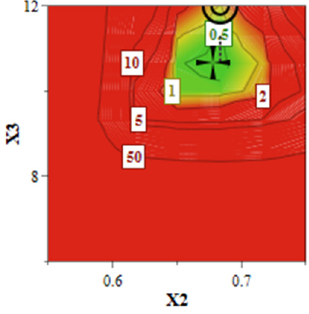
Figure 5. The Design Space of SIM-DOX-LCL formulation. X 2 : DOX concentration (mM); X 3 : SIM concentration (mM). Table 4. The composition of the optimal formulation and its actual physicochemical characteristics vs. predicted ones.